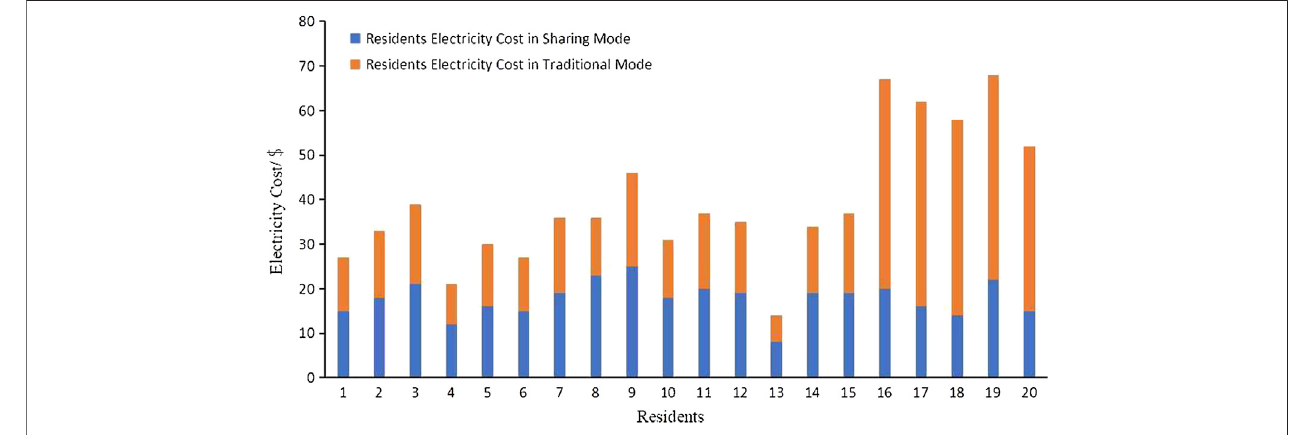
FIGURE 3 | Electricity charges for residents under the two modes.